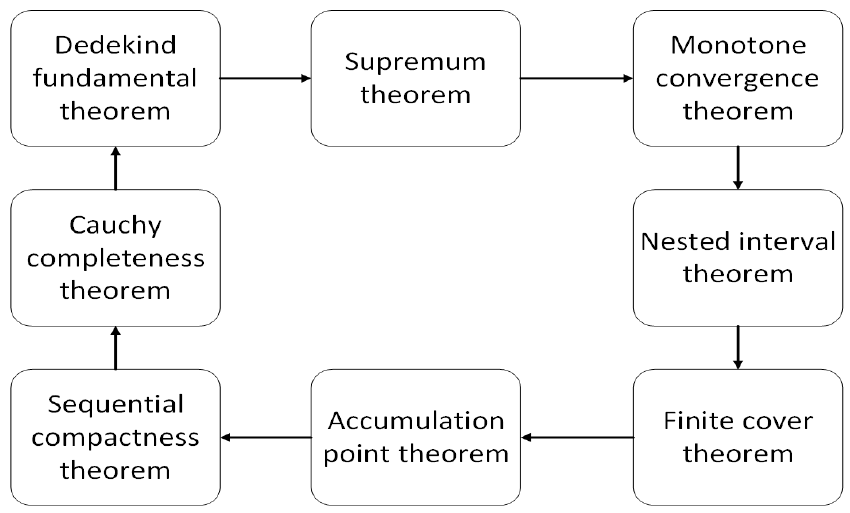
Figure 1. The cyclic proof of equivalence among completeness theorems of real